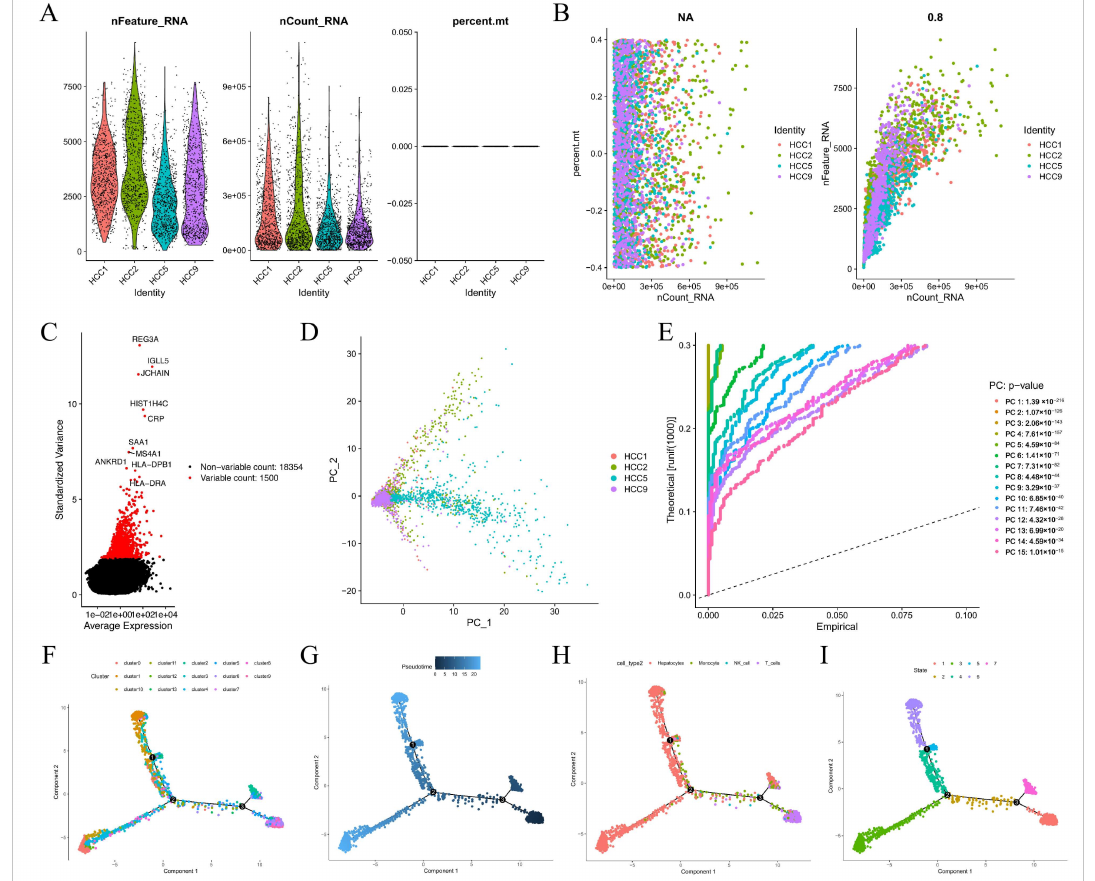
Figure 2. Annotation of 14 cell clusters in HCCs preprocessing scRNA-seq data displays high cell heterogeneity. ( A ) After quality control and normalization, 3200 cells from 4 HCC samples from GSE146115 were considered for further analysis. ( B ) The sequencing depth was not associated with the mitochondrial gene sequences detected, and a significant positive correlation was tested between sequencing depth and total intracellular sequences. ( C ) A total of 18354 corresponding genes and 1500 highly variable genes were displayed. ( D ) PCA analysis showed that no obvious differen- tiation did not occur in HCC cells. ( E ) 14 PCs were identified with an estimated p -value < 0.001. ( F – I ) Pseudo-time and trajectory